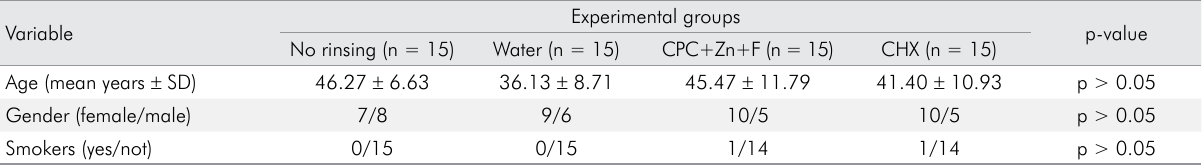
Table 1. Demographic characteristics (n = 60). Variable